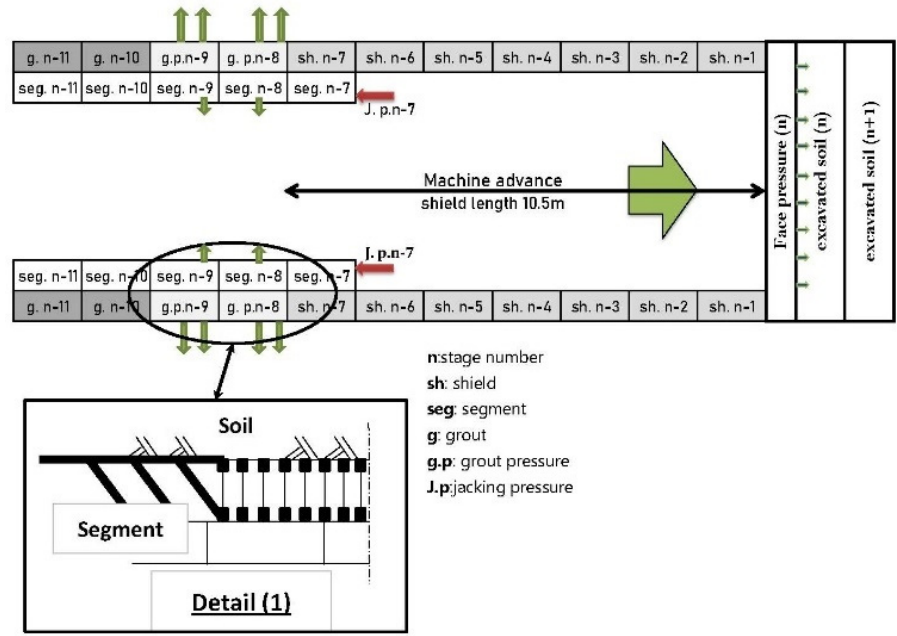
Figure 13. Construction stages.